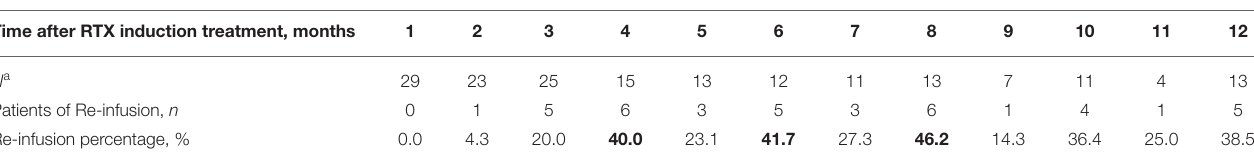
TABLE 3 | Presentation of the re-infusion time after RTX induction treatment.